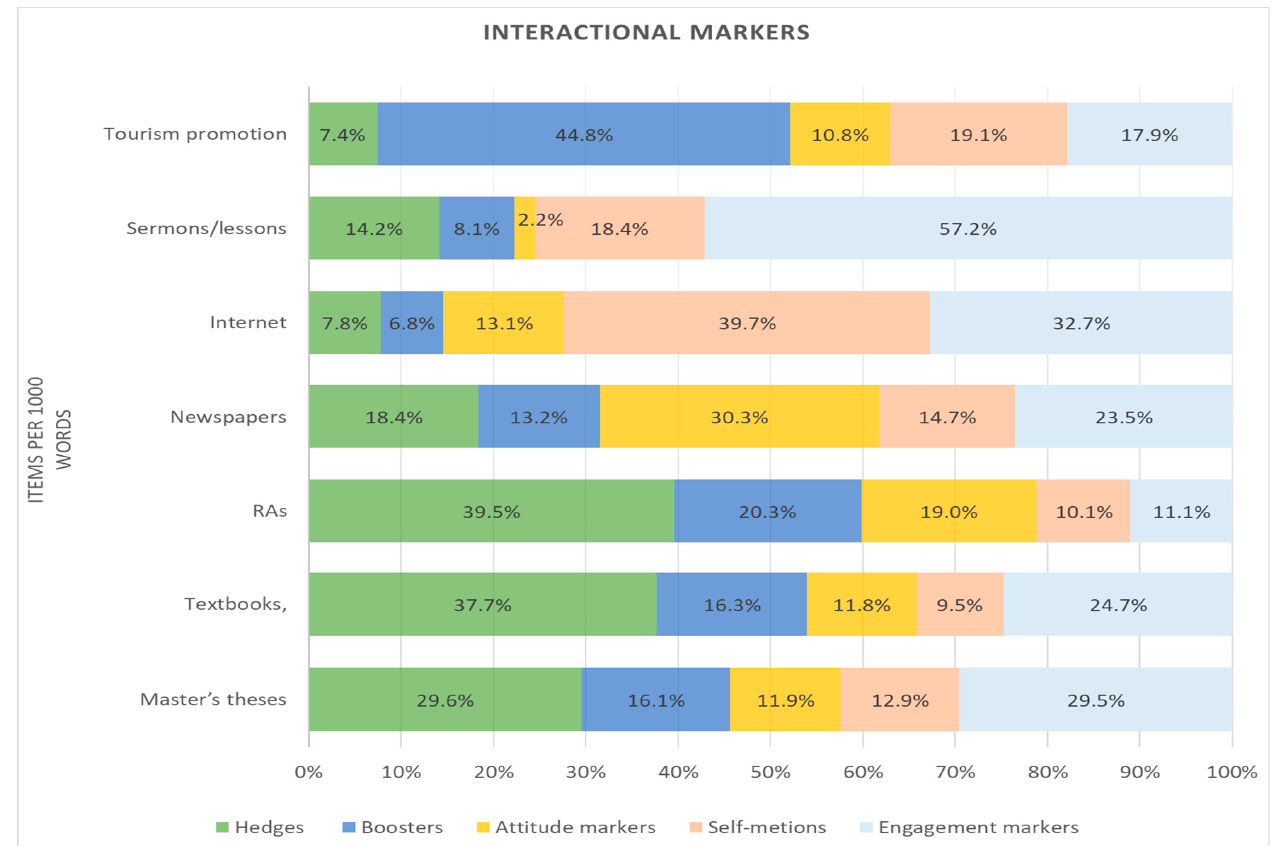
Figure 8. Interactional markers (percentage of appearance per 1000 words).